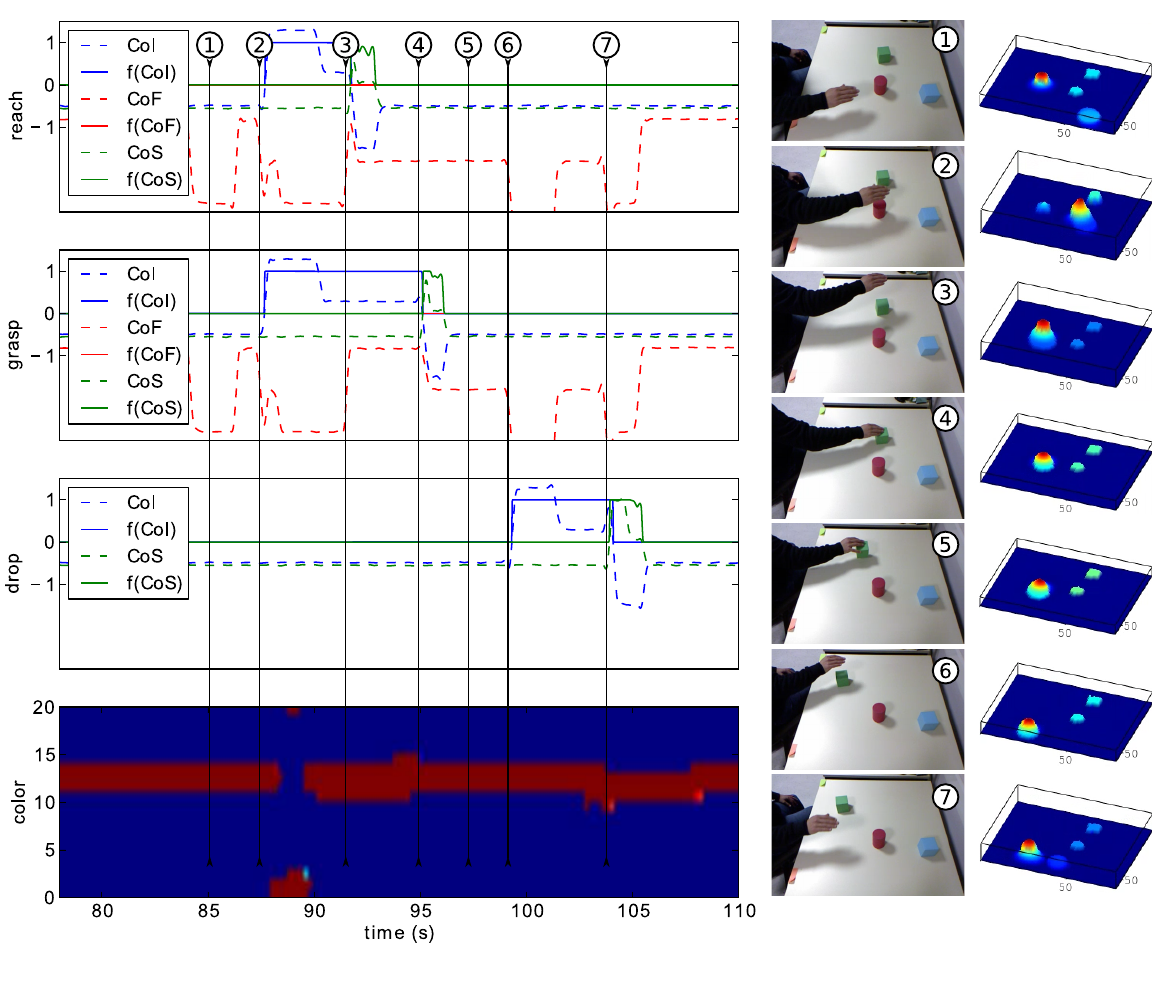
Figure 6: Time courses and activation snapshots of the architecture for a demonstration in which an actor moves its hand above a red object, stops on a green object, and transports it away. The activation in the DF on the bottom left is color coded with blue denoting sub- threshold and red denoting suprathreshold activation. See text for details.